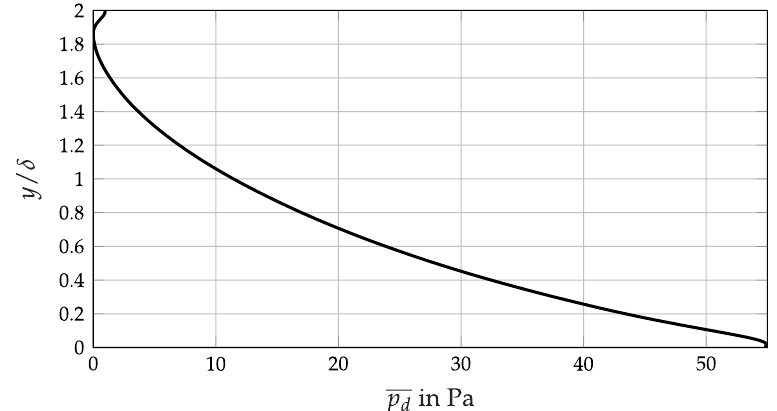
Figure 14. Wall-normal average dynamic pressure profile ahead of the stable flame front at atmospheric pressure and U b = 20ms − 1